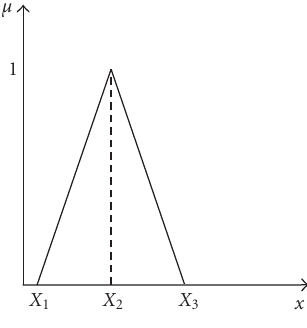
Figure 4.2. Fuzzy set for considerably large, moderately large, or fairly